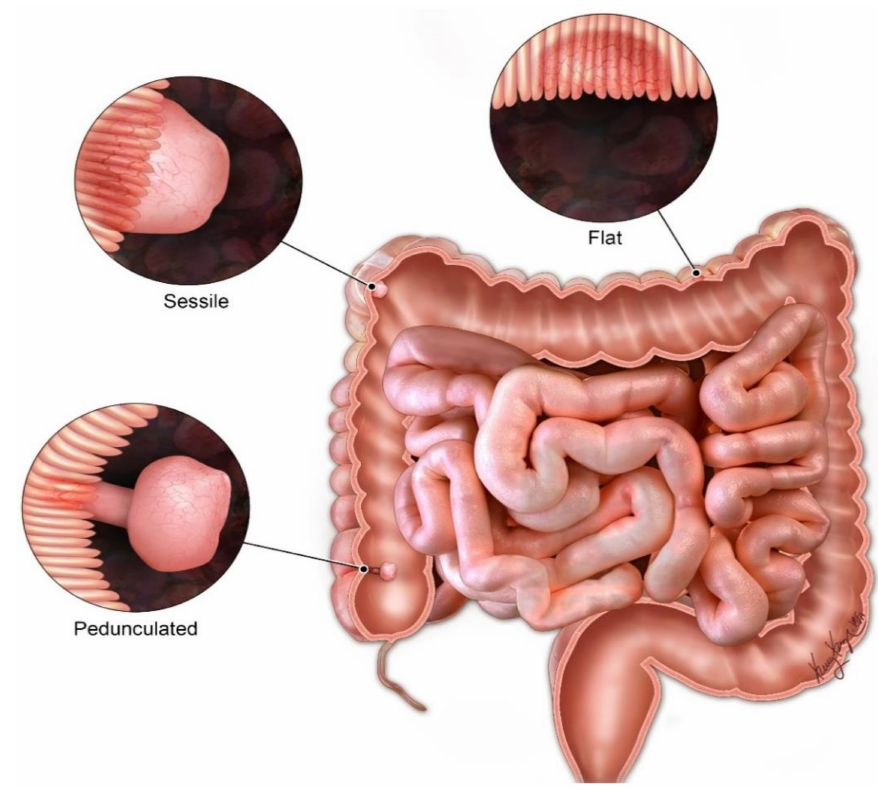
Figure 3. Different types of GIT polyps in PJS.